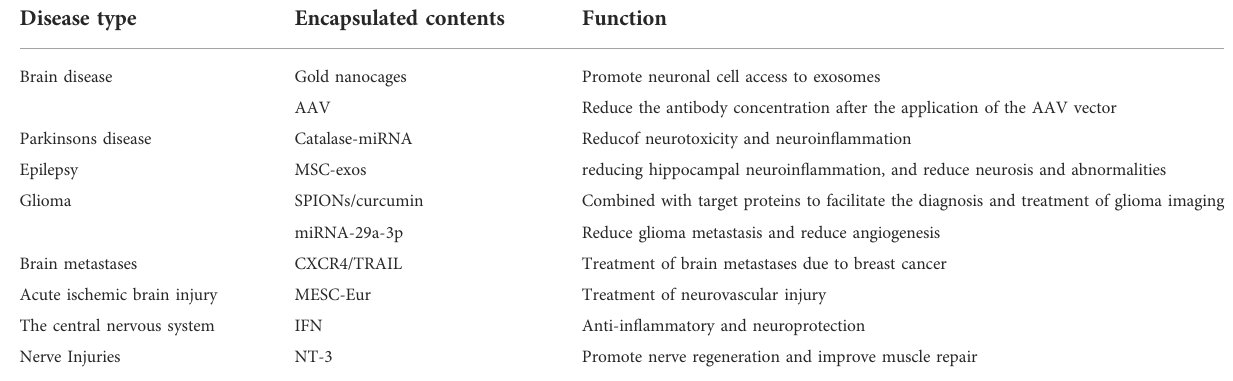
TABLE 6 Engineered exosomes in the nervous